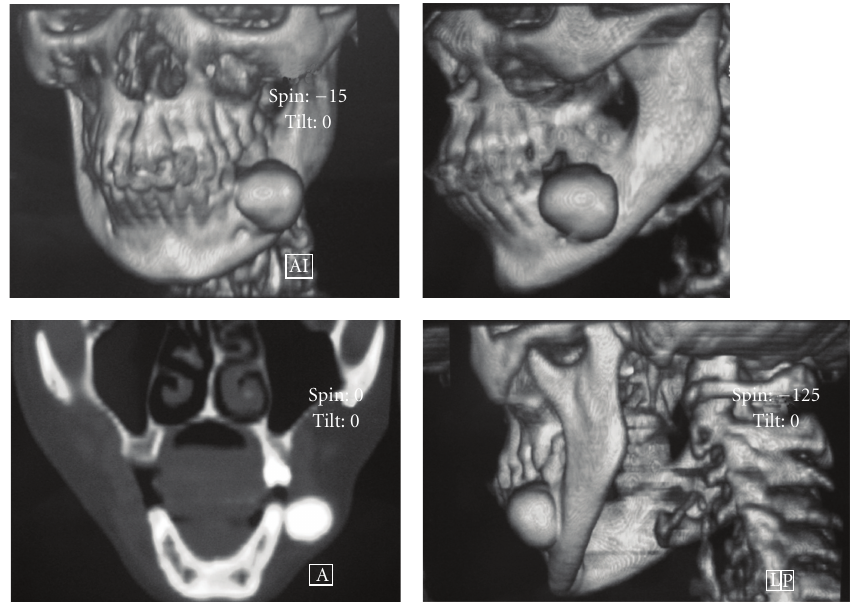
Figure 4: Coronal Computed tomography (CT) showing a large, well-circumscribed, pedunculated mass attached to the buccal surface of the left mandibular body. Three-dimensional reconstruction image showing localisation and extending of the lesion.